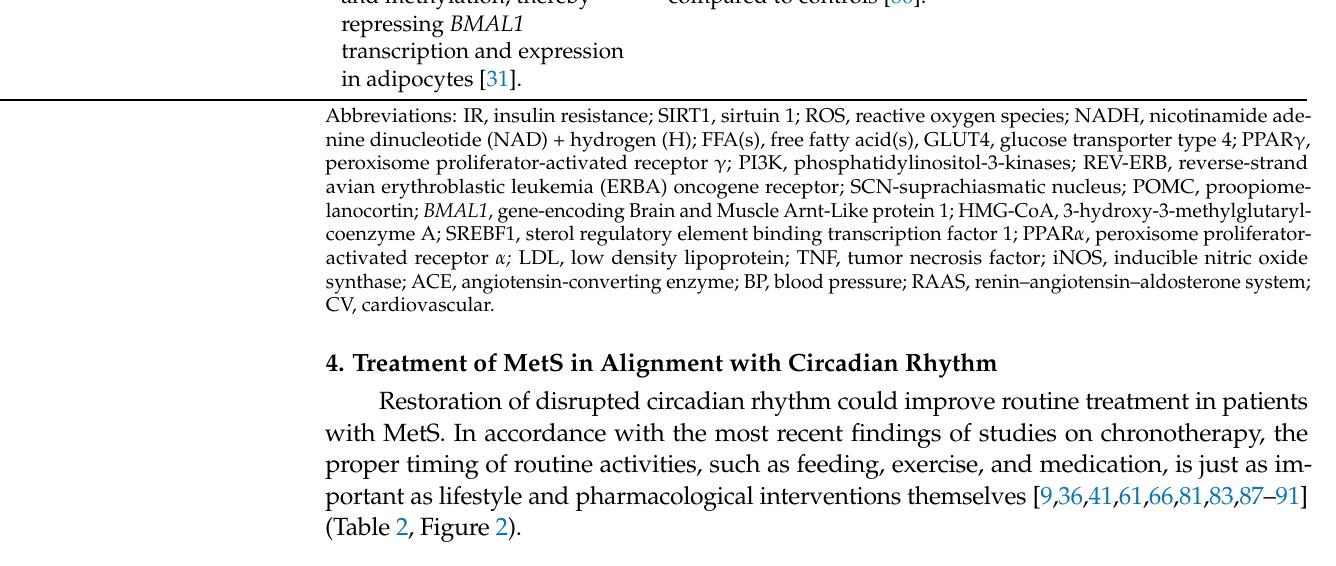
Table 2. Summary of treatment recommendations for patients with MetS, with regards to the circadian